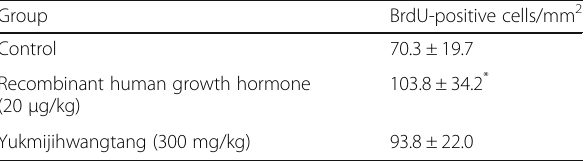
Table 3 Numbers of BrdU-positive cells in the growth plate Group